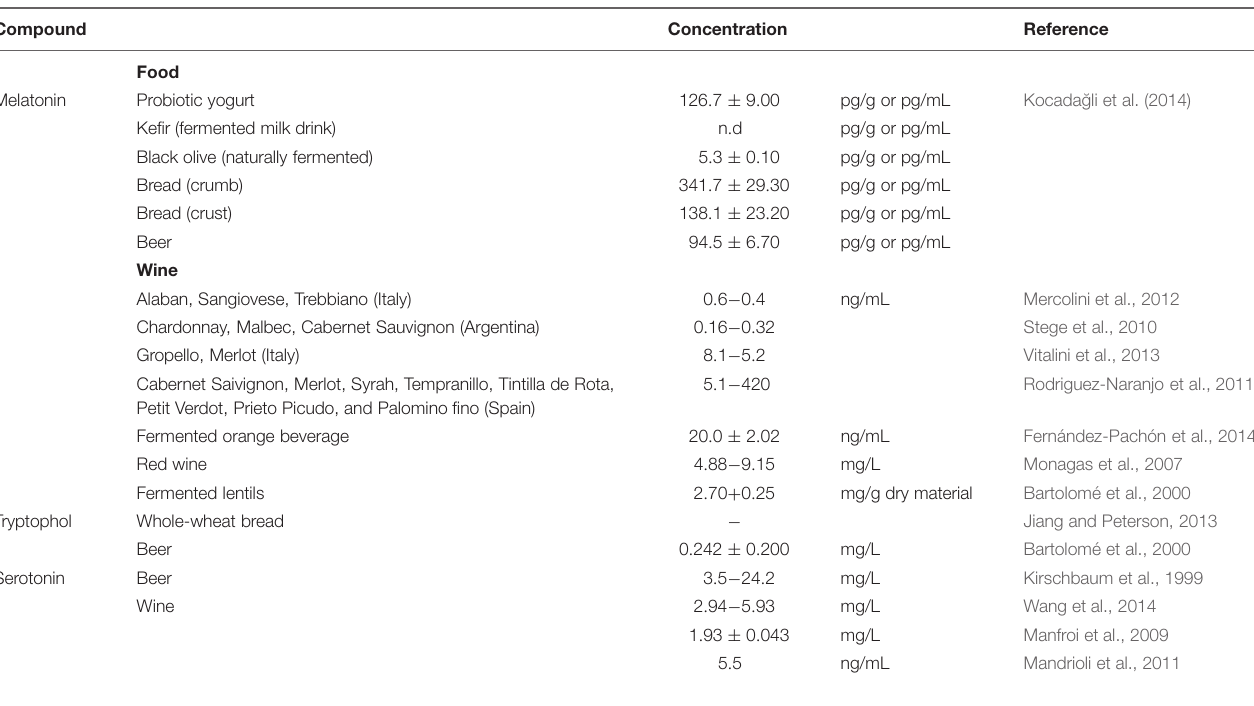
TABLE 1 | Concentration of melatonin and other tryptophan metabolites in fermented products.